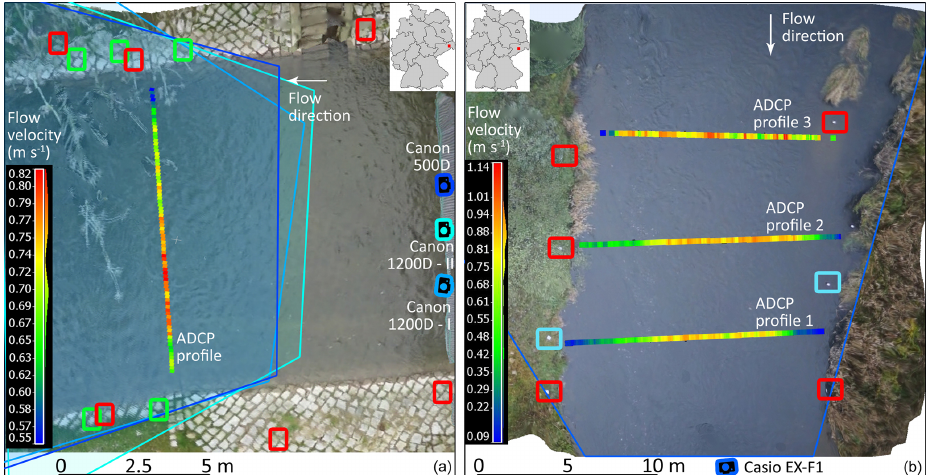
Figure 1. Areas of interest at the Wesenitz (a) and the Freiberger Mulde (b) displayed with UAV orthophotos calculated from video frames. Surface flow velocities measured with an ADCP and the corresponding locations of the measurement cross sections within the river are illustrated. Ground control points are used to reference the image data at both river reaches. Red squares highlight GCPs used for terrestrial and UAV data at the Freiberger Mulde and UAV data at the Wesenitz. Green squares show the location of GCPs used for terrestrial imagery at the Wesenitz. Check points (blue squares) are used to assess the accuracy of the 3D reconstruction from video frames at the Freiberger Mulde. Camera locations of the terrestrial image sequence acquisition are illustrated as pictograms, and corresponding image extent areas are shown (displayed area of interests in RGB correspond to the aerial image